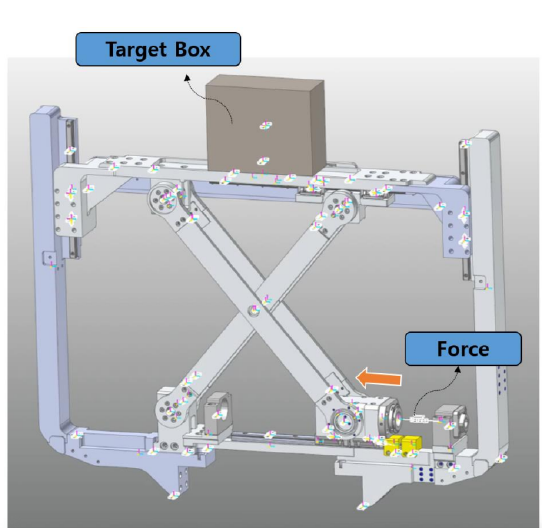
Figure 10. CAE analysis environment based on 3D design for scissor mechanism